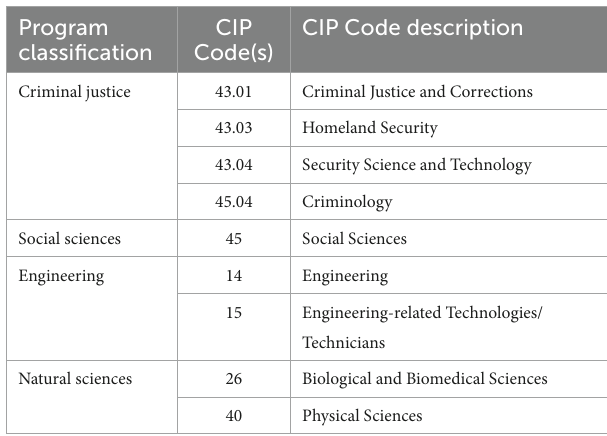
TABLE 2 The Classification of Instructional Programs (CIP) codes used to construct various majors for the purpose of data